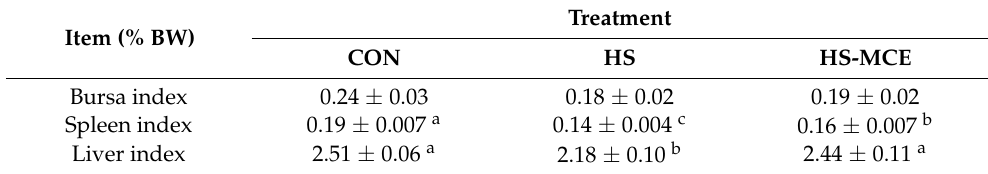
Table 3. Effects of HS and MCE on organ indices of yellow-feathered